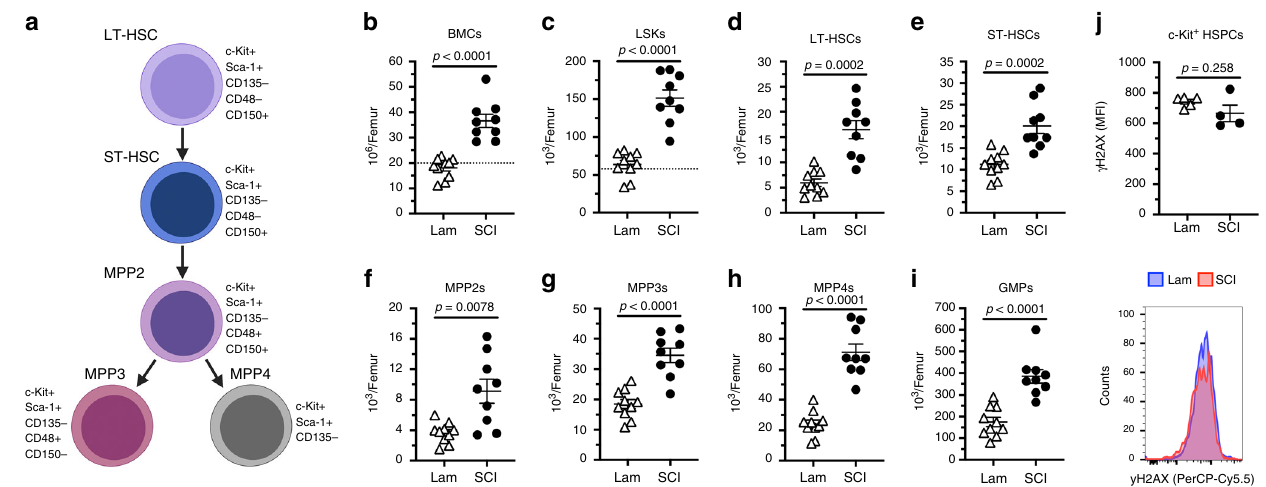
Fig. 2 T3 transection SCI causes the chronic accumulation of hematopoietic stem cells and differentiated progenitors. a Hematopoietic hierarchy of HSPCs and their cell surface markers. Total number of bone marrow cells ( b ), LSKs ( c ), long-term HSCs ( d ), short-term HSCs ( e ), multipotent progenitors 2 – 4 ( f – h ), and granulocyte – monocyte progenitors ( i ) at 28 dpi. j Mean fl uorescence intensity of yH2AX expression (i.e. replication stress) within c-Kit + HSPCs at 28 dpi. All data are mean ± SEM, two-sample t -test; n = 9 and 10/group ( b – i) , n = 5 and 4/group ( j ). Dotted lines represent average data from naïve mice. dpi days post-injury, Lam laminectomy (sham injury). Source data are provided as a Source Data fi